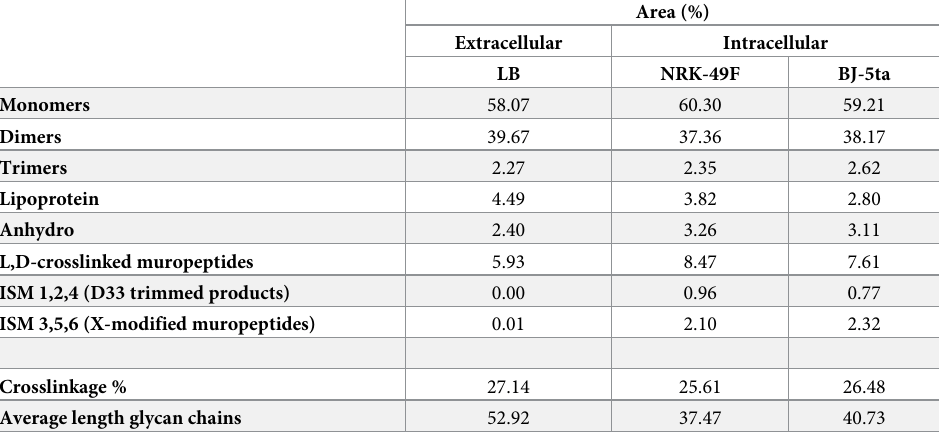
Table 1. Quantification of structural parameters in the PG of extracellular and non-proliferating intracellular S .